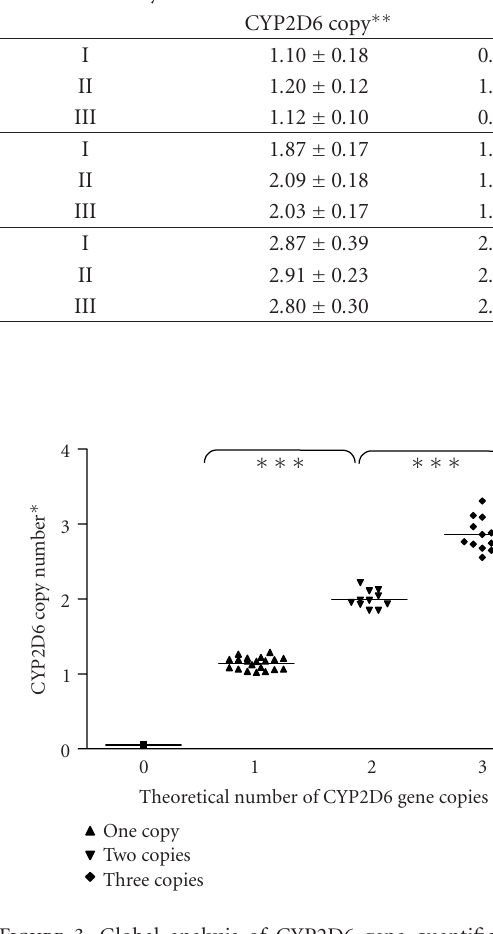
Figure 3. Global analysis of CYP2D6 gene quantification in 44 DNA samples based on three independent experiments. The analysis of gene copy number was performed using the formula 2 ∗ 2 − ∆∆ Ct+ / − SD . The three groups are significantly di ff erent with P < . 001 (ANOVA). Means are realized from the averages of the final results of each run after 2 ∗ 2 − ∆∆ Ct+ / − SD calculation. ∗ de- notes gene copy number after Southern blotting and long PCR